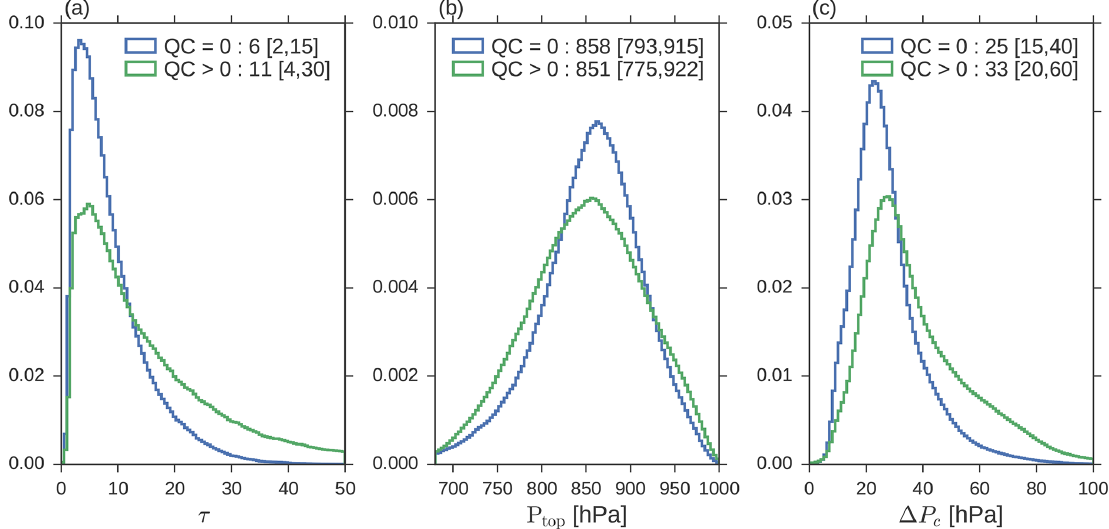
Figure 11. Distributions of retrieved cloud properties over the full OCO2CLD-LIDAR-AUX dataset, split by Quality_flag = 0 (QC = 0 in legend) or Quality_flag > 0. (a) Cloud optical depth. (b) Cloud top pressure. (c) Cloud pressure